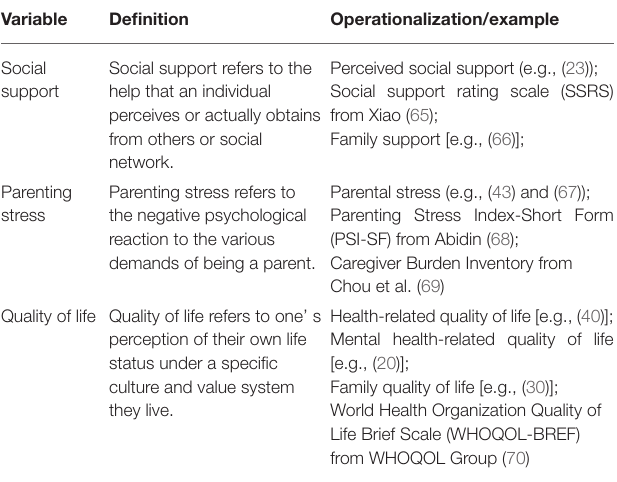
TABLE 1 | Definition and examples of key variables. Variable